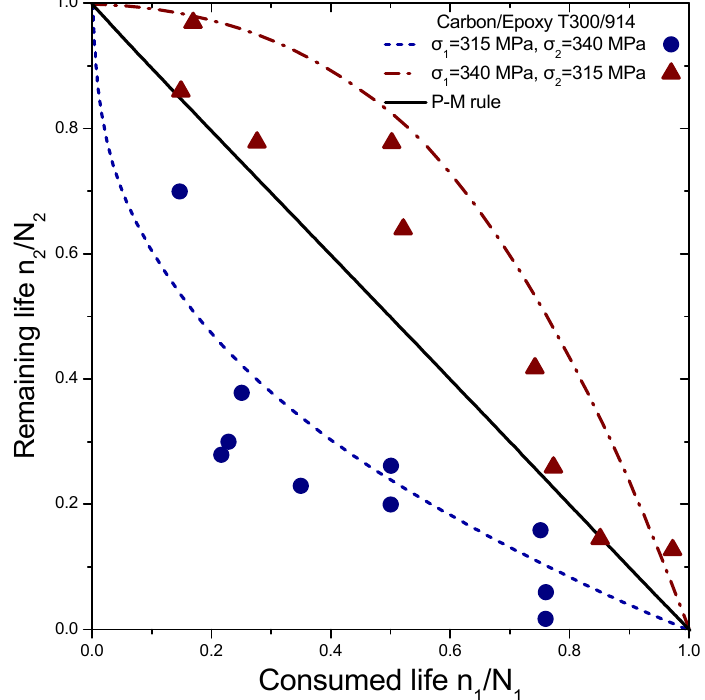
Figure 5. Analytical prediction of remaining life versus consumed life for the case of carbon/epoxy (T300/914). The experimental data points are taken from Ref. [16].